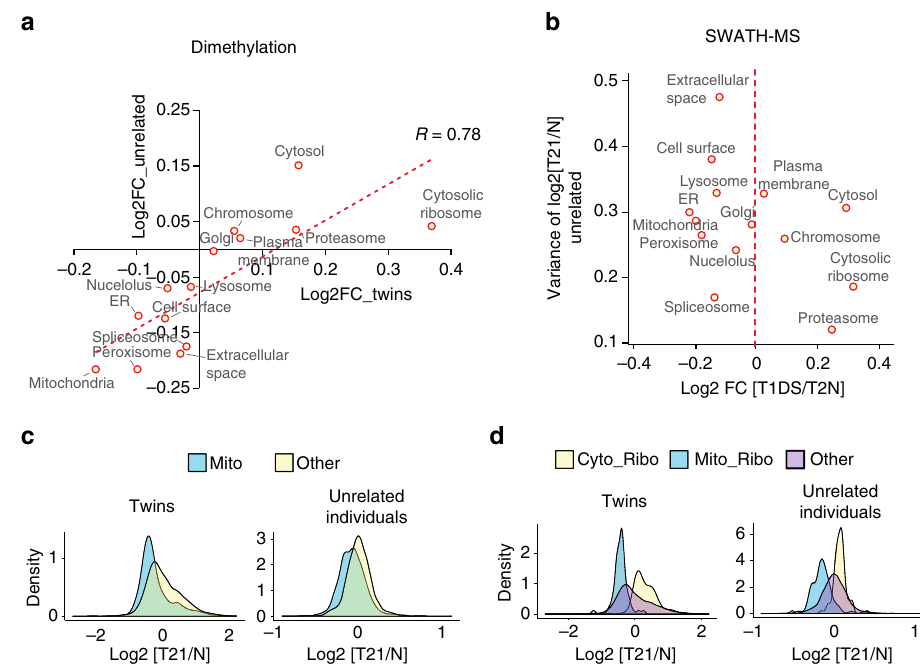
Fig. 6 Inter-individual variability of organelle proteome alternations induced by T21. a High correlation of organelle proteome regulation trends between twins and unrelated samples. b The correlation between log 2 T1DS/T2N ratios for each organelle and the inter-individual variability of T21/normal FC using unrelated samples. ER, endoplasmic reticulum. c The distribution of T21/normal ratios of mitochondrial proteins and other proteins in the proteome, for twin samples and unrelated individuals. d The distribution of T21/normal ratios of cytosolic ribosome proteins (Cyto_Ribo), mitochondrial ribosome proteins (Mito_Ribo), and other proteins in the proteome, for twin samples and unrelated